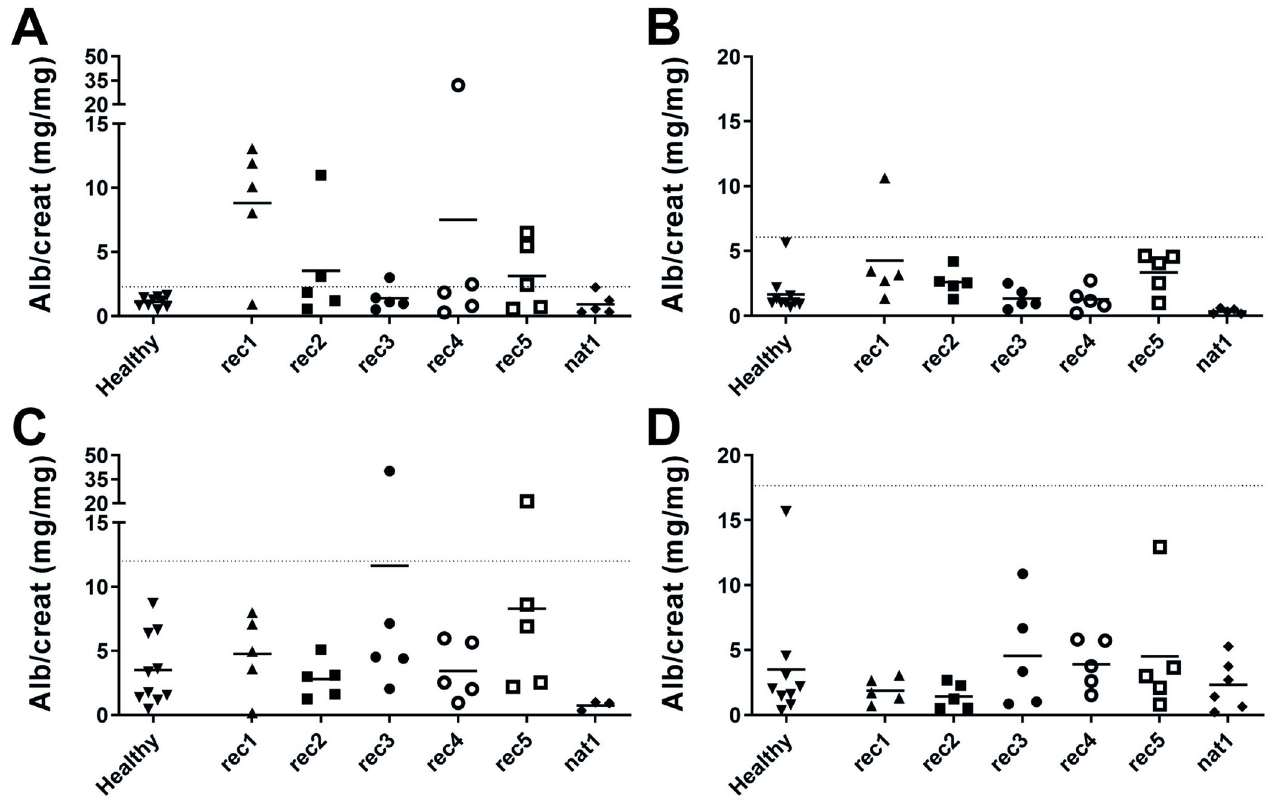
Fig 2. Proteinuria of Balb/c Thy-1.1 and C57BL/6 Thy-1.1 mice induced by FSGS plasmas. ( A ) Balb/c Thy-1.1 males, ( B ) Balb/c Thy-1.1 females, ( C ) C57BL/6 Thy-1.1 males, and ( D ) C57BL/6 Thy-1.1 females were injected intravenously, at 5 weeks ± 3 days old, with 2 mg (Balb/c Thy-1.1 males), or 12 mg (Balb/c Thy-1.1 females, C57BL/6 Thy-1.1 males and females) PP effluent protein from six patients with presumed CPF(s). Individual animal data and group means of urinary albumin/ creatinine (alb/creat, mg/mg) ratio are presented. Data of healthy plasma injections from Fig 1 are shown for comparison with patient PP effluents. Mice were defined as responding to patient PP effluent if proteinuria exceeded the mean plus 3 times the standard deviation of proteinuria of healthy plasma-injected mice (indicated with dotted lines).